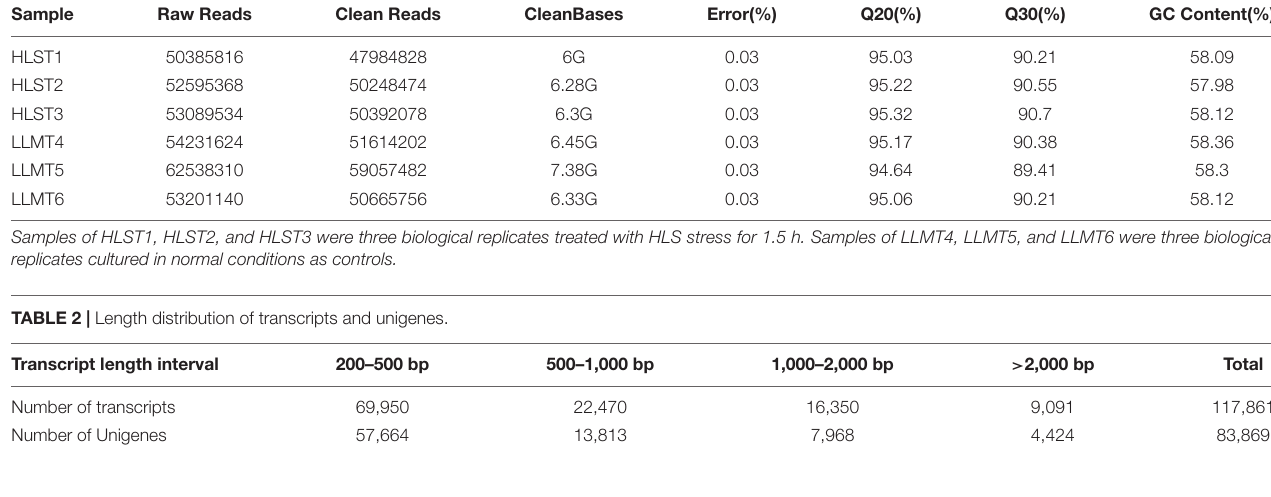
with Chlamydomonas reinhardtii ( Supplementary Figure 1 ).